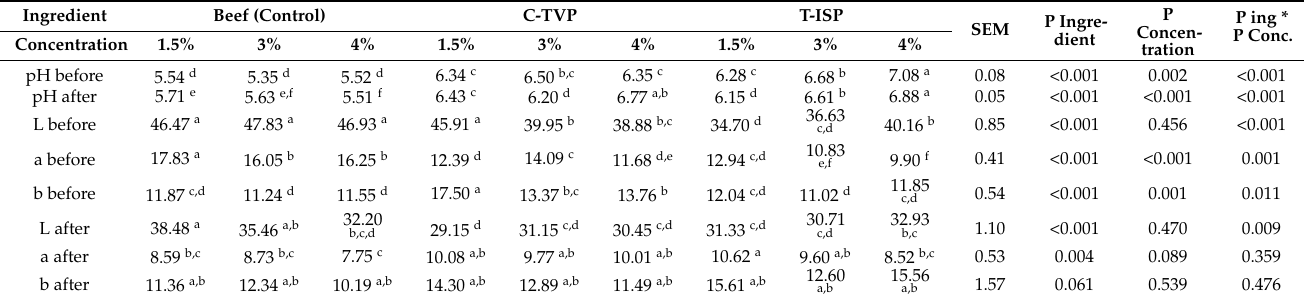
Table 3. Physiochemical characteristics of plant-based meat and control (beef) with different concentration of methylcellulose.